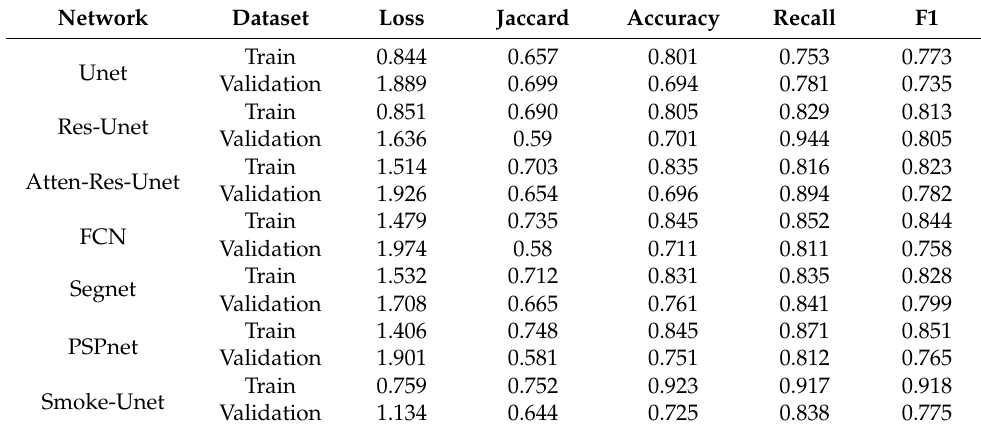
Table 4. Ablation and comparative analysis of different